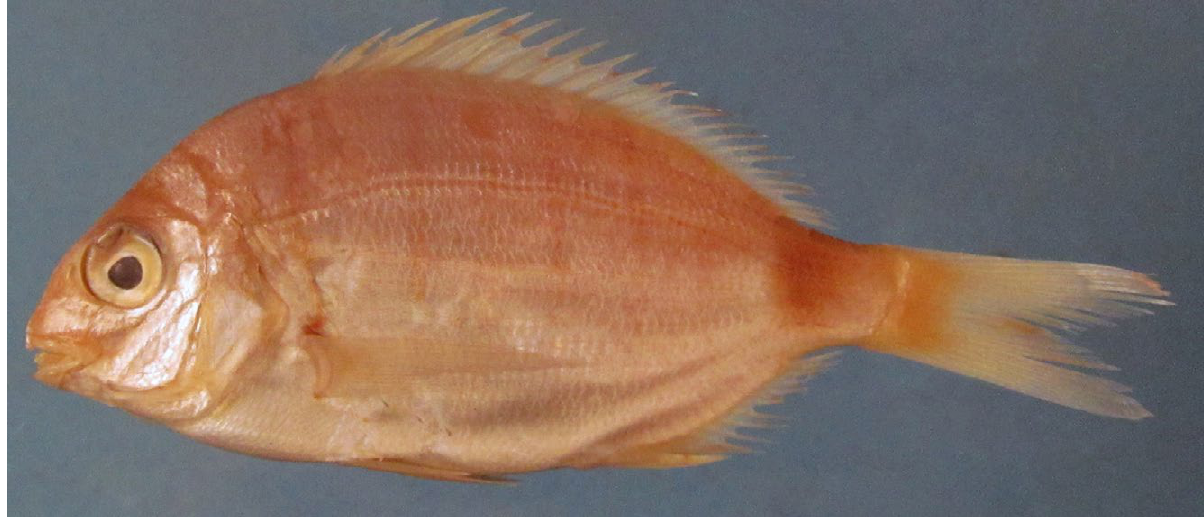
Fig. 11. – Diplodus sargus , HUJ 6047, neotype of Sargus raucus Geoffroy Saint-Hilaire 1809, 64.3 mm SL, Bardawil Lagoon, Egypt (Pho- tograph: D.